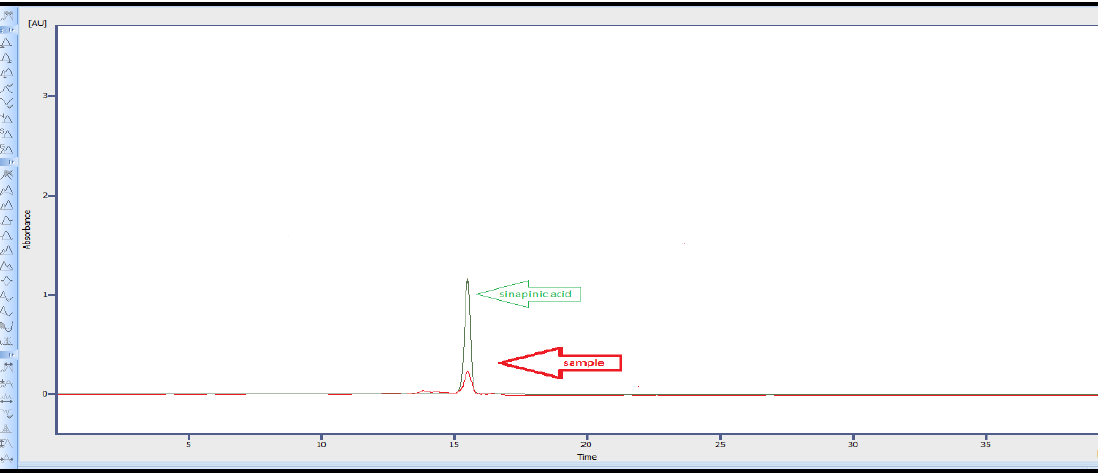
Figure 16. HPLC chromatogram of the isolatedi compound number 2 and Sinapic acide standard.